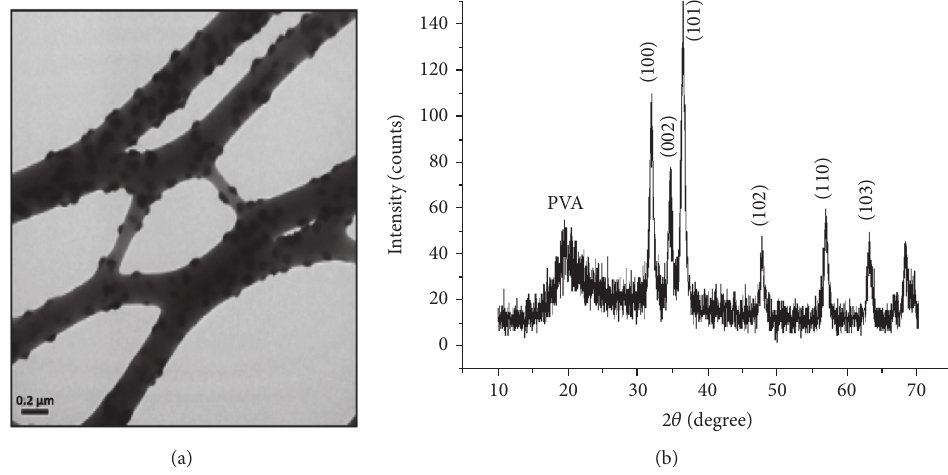
Figure 2: TEM image (a) and XRD spectra (b) of ZnO-3.